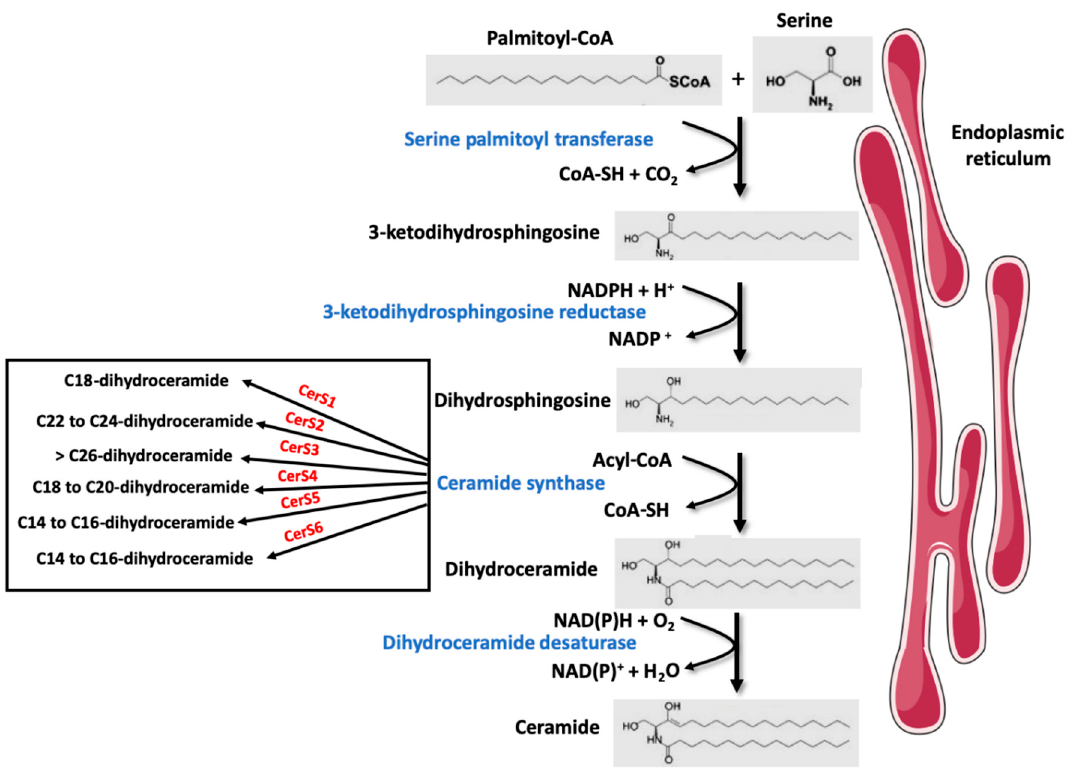
Figure 1. Ceramide de novo synthesis pathway.